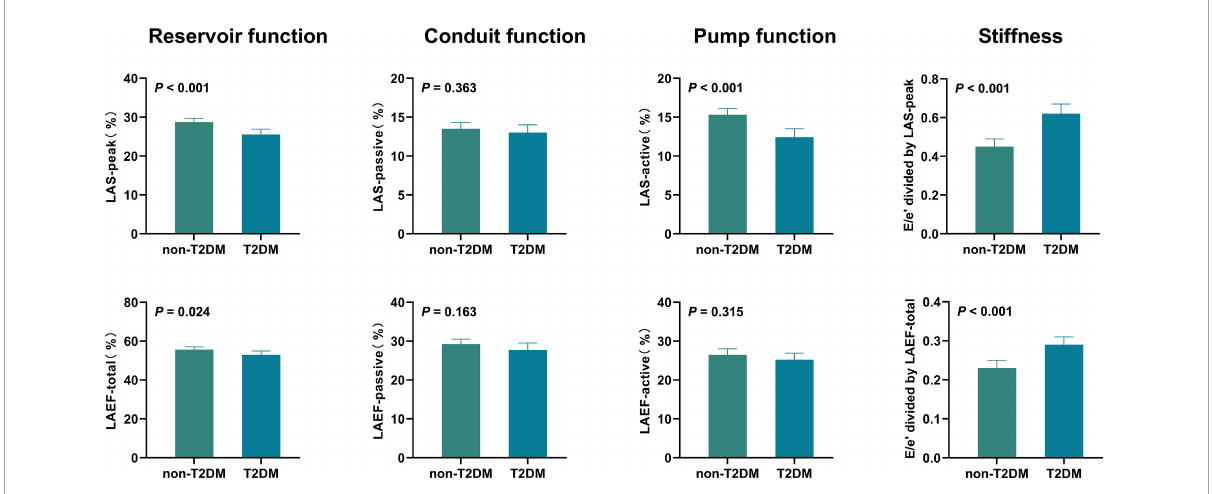
FIGURE1 Unadjusted comparisons of LA function and stiffness between HFpEF patients with and without T2DM HFpEF, heart failure with preserved ejection fraction; LA, left atrial; LAS, LA strain; LAEF, LA ejection fraction; T2DM, type 2 diabetes mellitus.